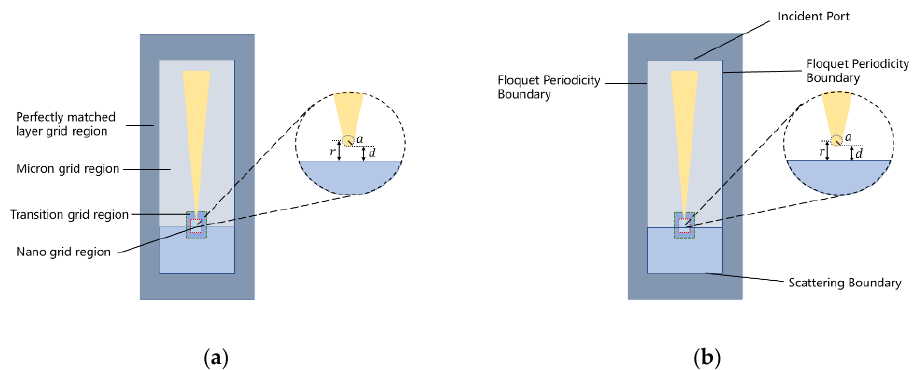
Figure 2. ( a ) Simulation of each area grid division; ( b ) simulation boundary condition setting.